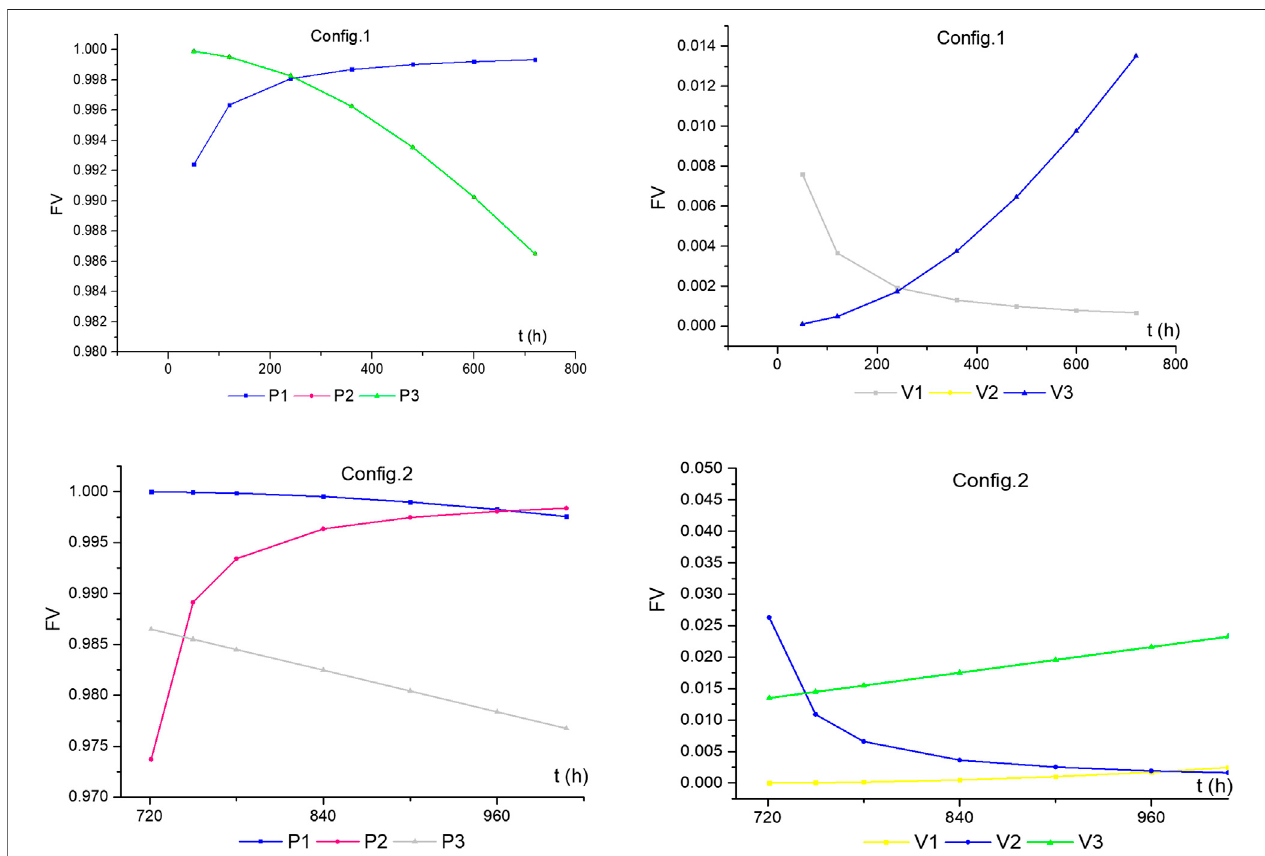
FIGURE 6 | FV importance of component (Con fi g.1 and